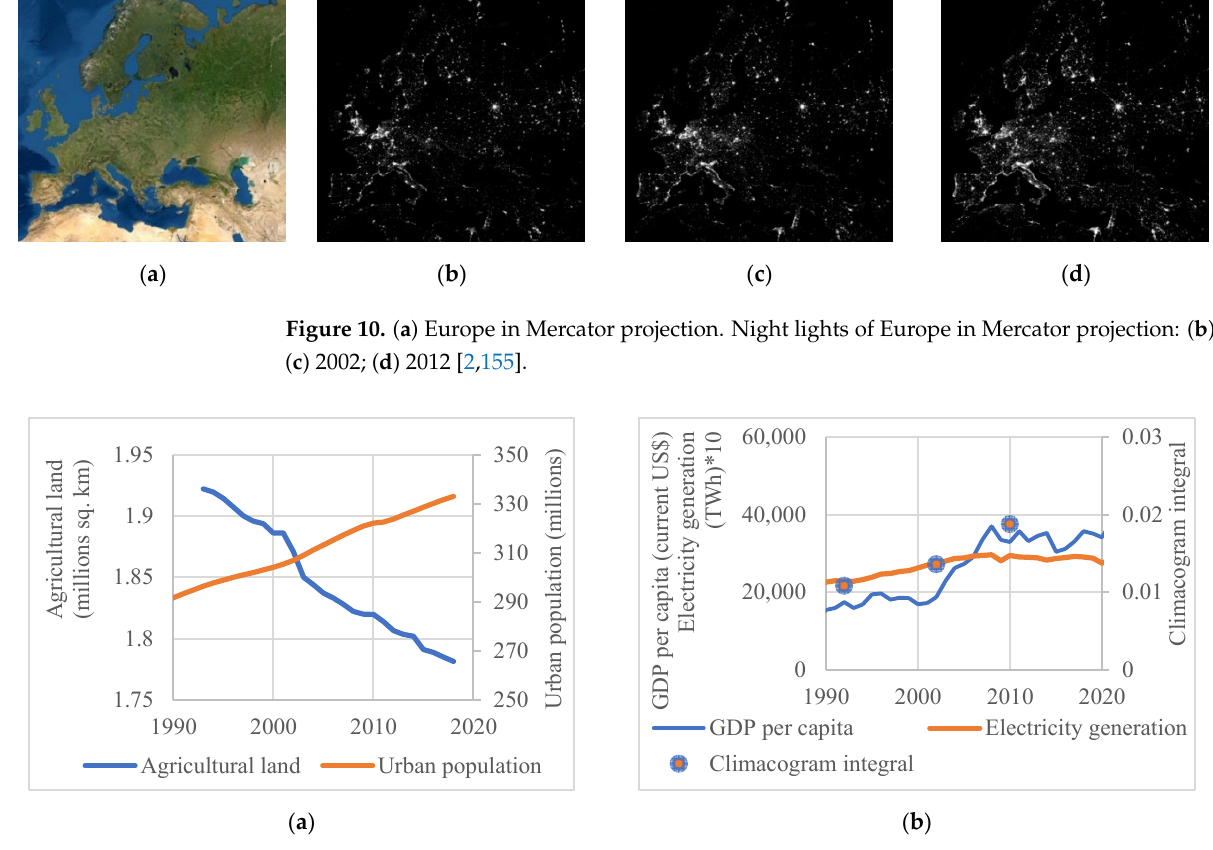
Figure 11. EU (1990–2020) ( a ) Agricultural land (data from [156]) and urban population (data from [157]); ( b ) GDP per capita (data from [158]), electricity generation (data from [106]), and clustering indicator (Climacogram integral).